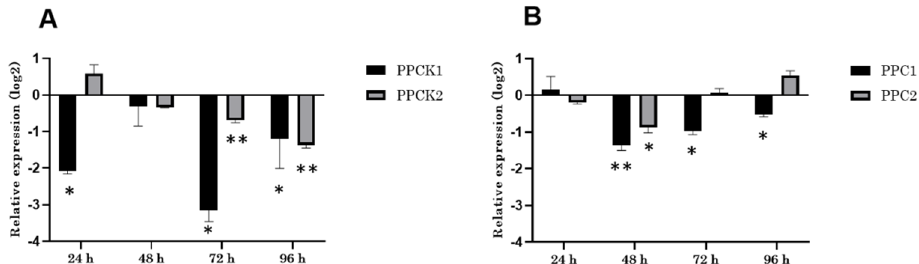
. Figure 3. Analysis of grapevine PPCK and PPC genes expression intact Gamay leaf in response to CD